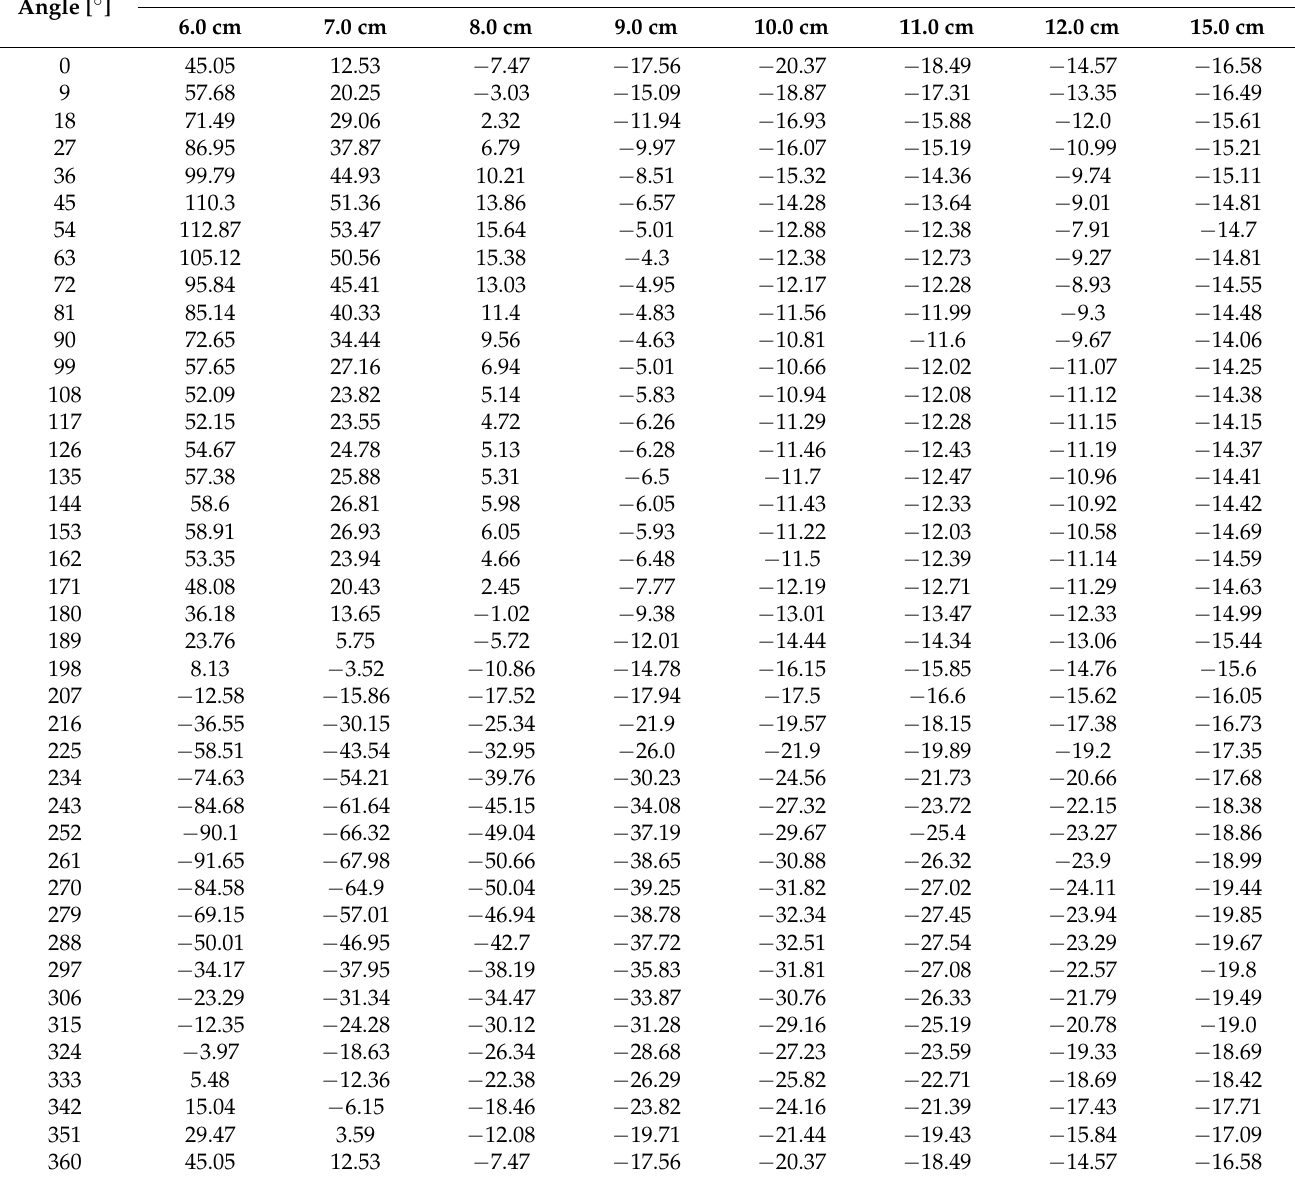
Table 3. Estimated values of the B x component of magnetic induction as a function of rotation angle and measurement distance.